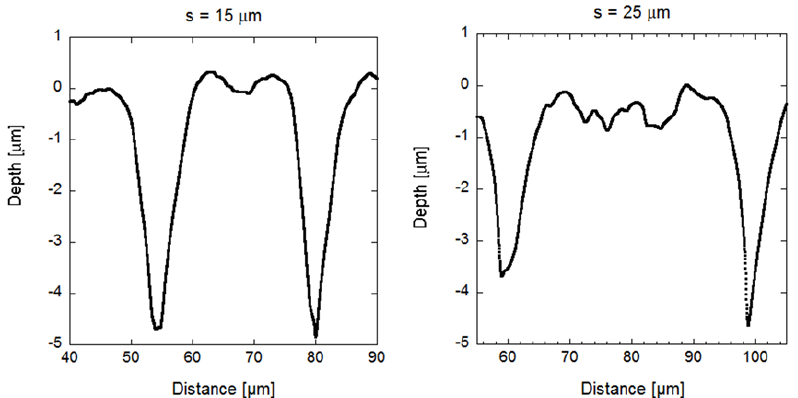
Figure 12. Topographical profile measured by profilometry of the laser-created grooves for an inter-groove spacing of 15 and 25 µ